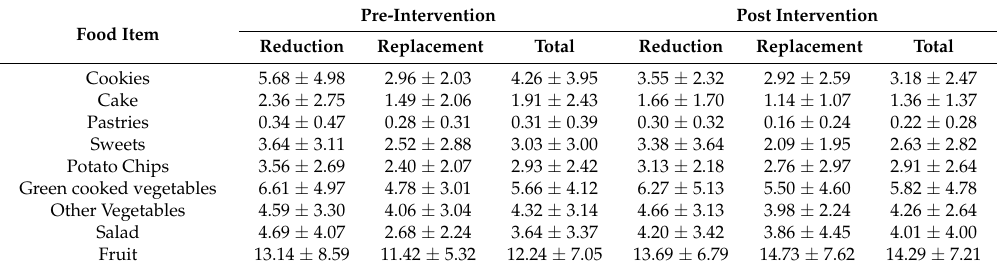
Table 5. Frequency of consumption pre and post intervention (mean ±